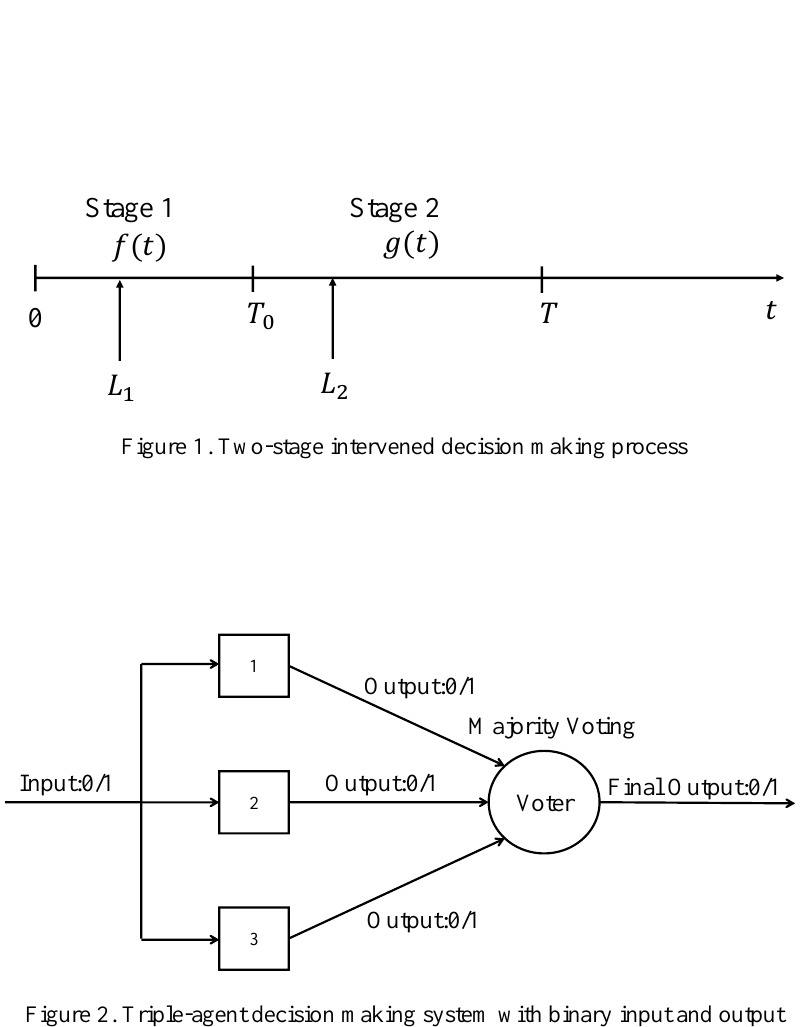
Figure 2. Triple-agent decision making system with binary input and